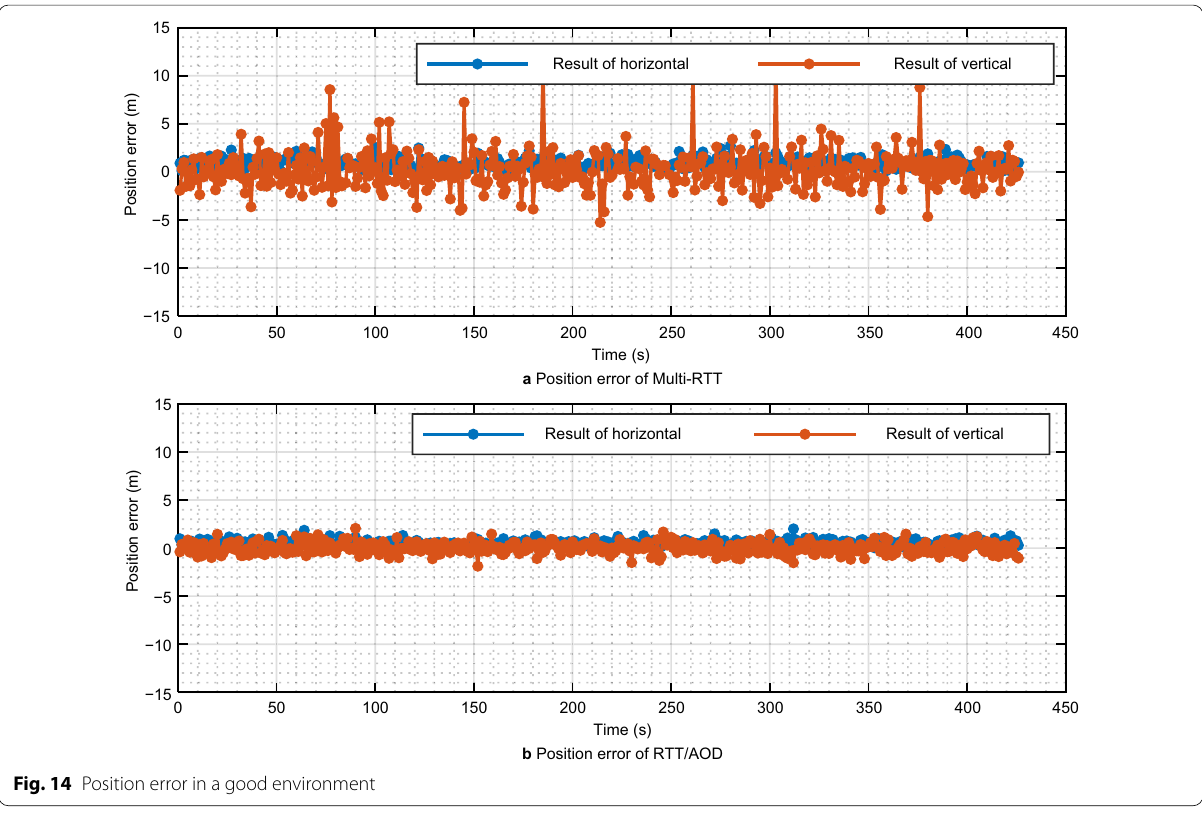
Fig. 14 Position error in a good environment